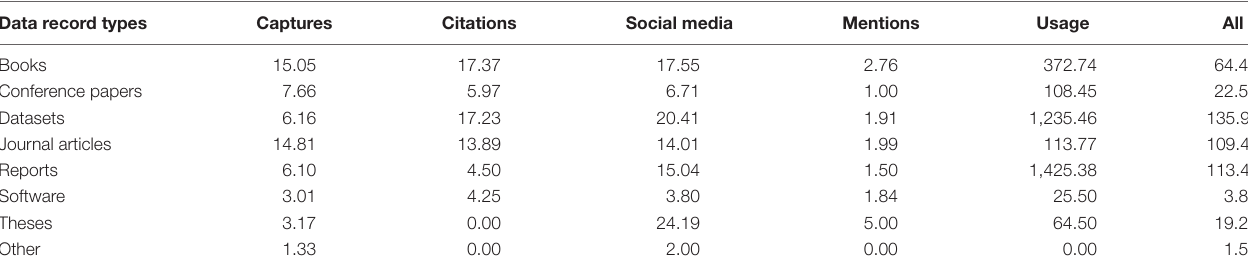
Table 7 | Results from PlumX: mean value of the available scores for each Zenodo data record type (all publication years). Data record types